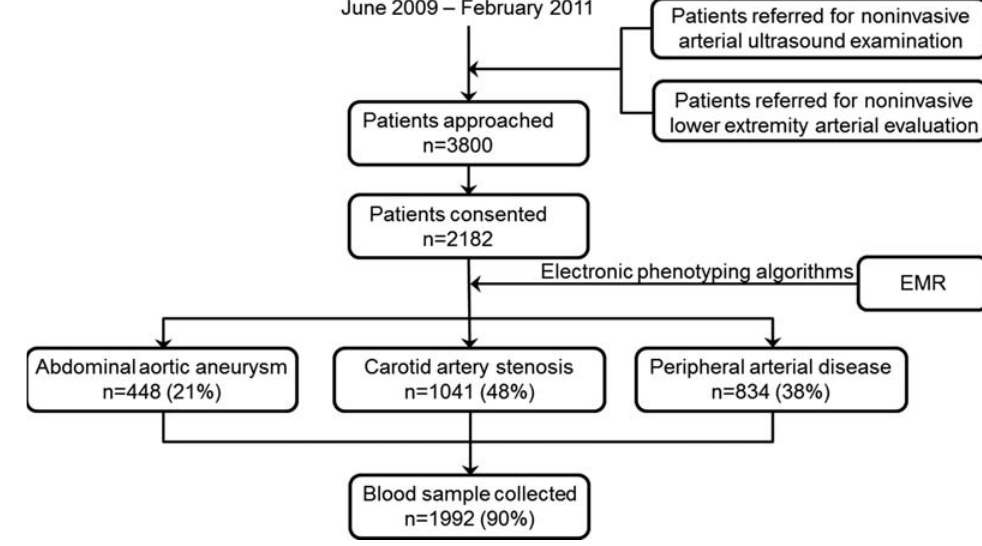
Figure 1. Pattern of recruitment for the Vascular Disease Biorepository. EMR ¼ electronic medical